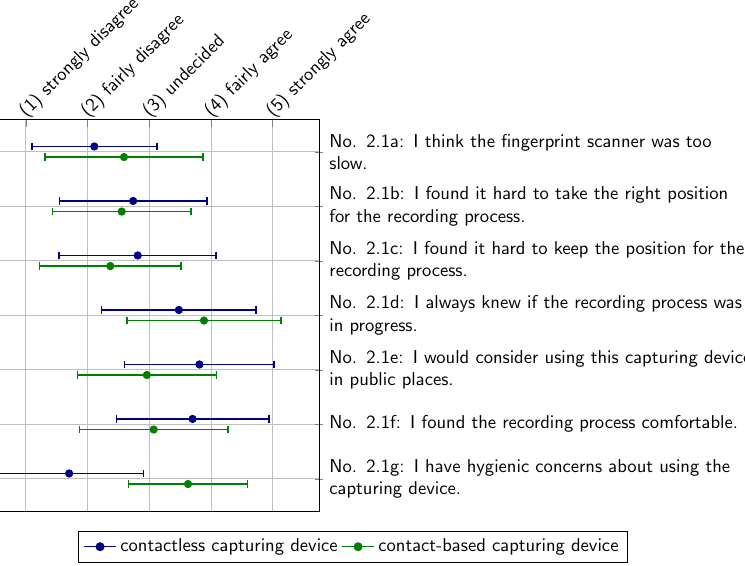
Figure 14. Usability assessment of the contactless and contact-based capturing device in comparison to each other.